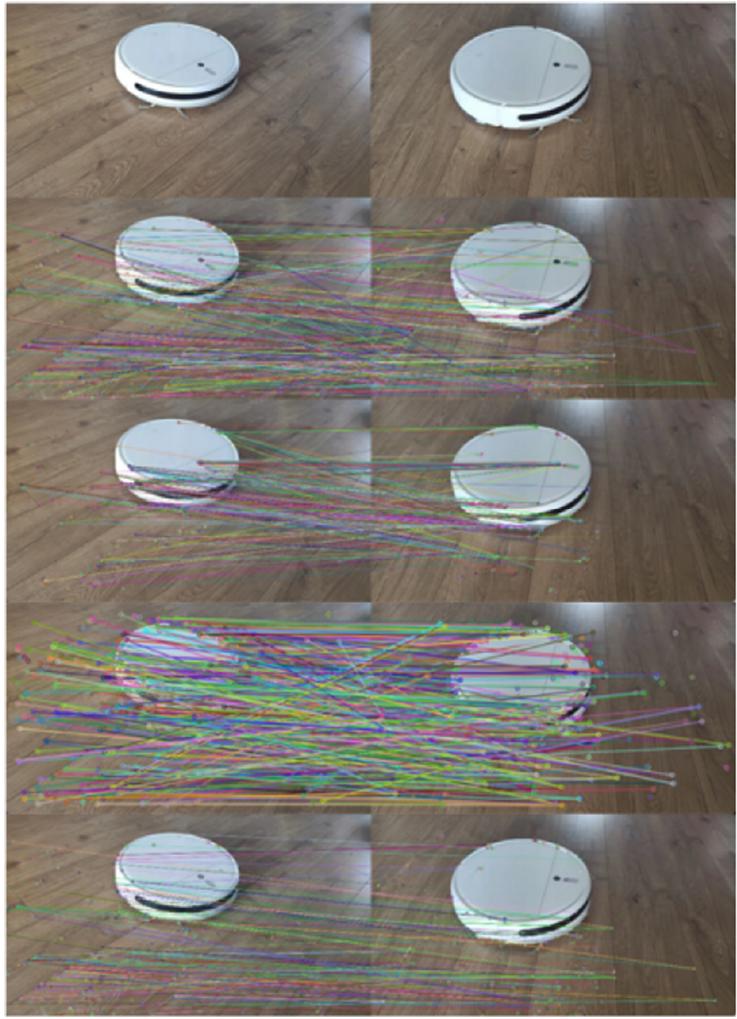
Figure 4. Feature-matching comparisons: Input images ( top ), SIFT feature-matching ( second row ), ORB feature-matching ( third row ), Super Point matching ( fourth row ) and finally, the proposed method matching ( bottom ). Table 1. Comparison of experimental results for Figure 4.